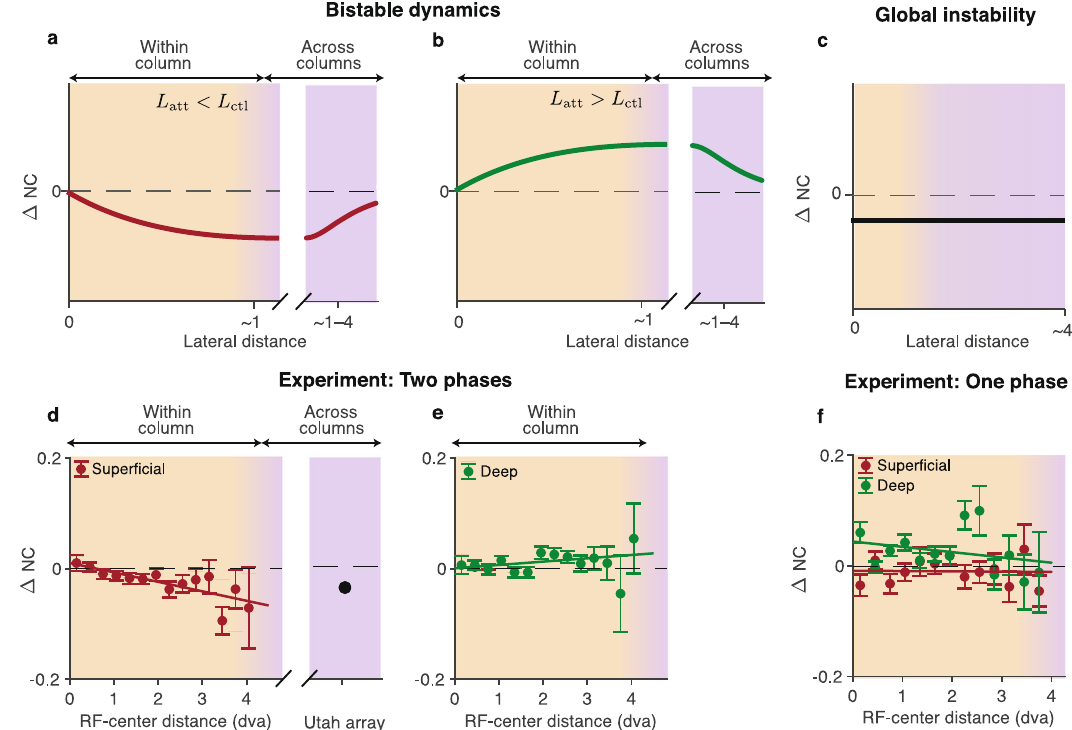
Fig. 6 Attentional changes in noise correlations depend on lateral distance. a Our model predicts that changes in noise correlations at intermediate lateral distances are driven by changes of the correlation length L . When the correlation length decreases ( L att < L ctl ), the model predicts a robust reduction of noise correlations at intermediate distances (across columns, purple background) when changes at zero distance are vanishing (crimson line). Over short distances (within the column, orange background), noise correlations progressively decrease with distance. b When the correlation length increases ( L att > L ctl ), our model predicts an increase of noise correlations at intermediate distances when changes at zero distance are vanishing (green line). In both cases ( a , b ), the spatial pro fi le of noise-correlation changes is not uniform, and sizable changes are predicted to occur at intermediate lateral distances. c The balanced network model with fl uctuations around a single global fi xed point predicts uniform changes in noise correlations at all distances (black line) 31 . d In two-phase recordings, changes in noise correlations during attention depend on the RF-center distance. The magnitude of noise-correlation changes is vanishingly small at zero distance and progressively increases at longer distances. With increasing RF-center distance, noise correlations decrease in super fi cial layers (crimson). Data for single columns (crimson dots - data, line - linear regression, n = 2544 MU pairs) are shown along with an approximate value of changes in noise correlation between neurons in different columns recorded with a Utah array (black dot). Error bars represent SEM. e Same as d for deep layers in two-phase recordings ( n = 3064 MU pairs). With increasing RF-center distance, noise correlations show a moderate increasing trend with borderline statistical effect. f Same as d , e for one-phase recordings. Changes in noise correlations during attention do not depend on the RF-center distance in super fi cial (crimson) and deep (green) layers (super fi cial layers n = 920 MU pairs; deep layers n = 1448 MU pairs). Source data are provided as a Source Data fi